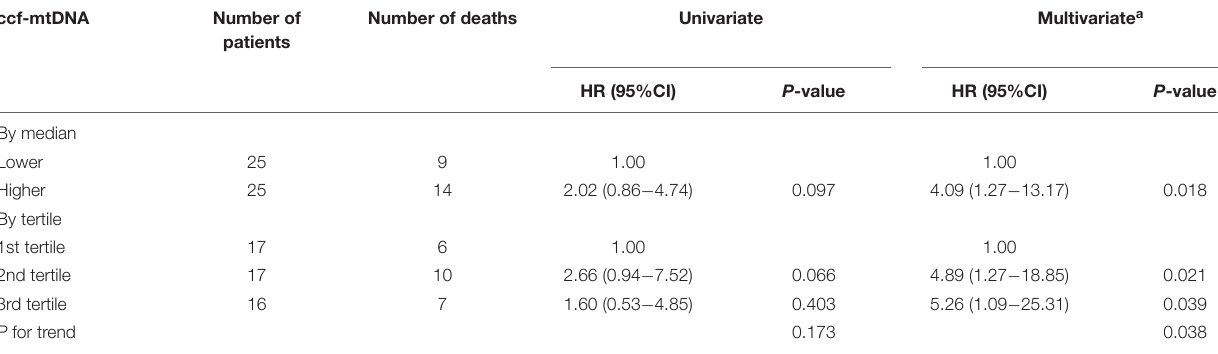
TABLE 4 | The association between ccf-mtDNA and overall survival of HBV-HCC patients with TACE and TCM treatments.